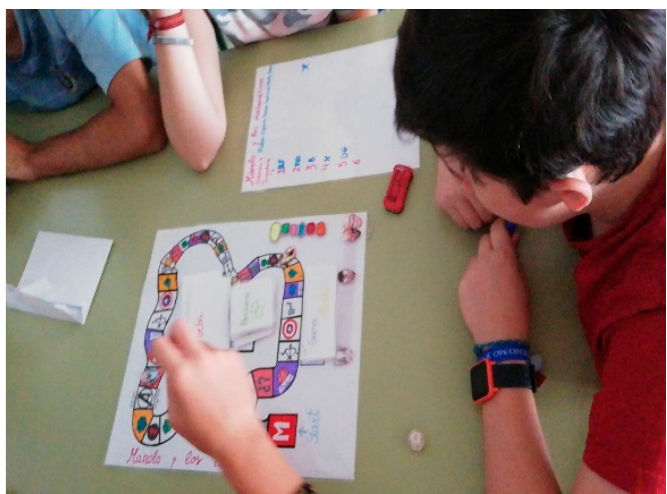
Figure 10. Students playing with one of the polyhedral games designed by them.